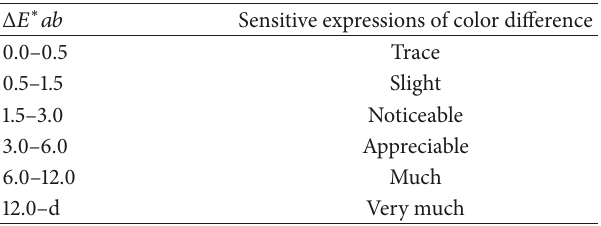
Table 3: Sensitive expressions of color difference by N.B.S Unit